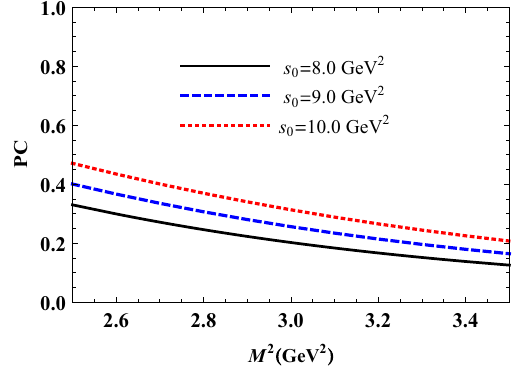
Fig. 1 The pole contribution in the case of the scalar tetraquark vs the Borel parameter M 2 at different s 0